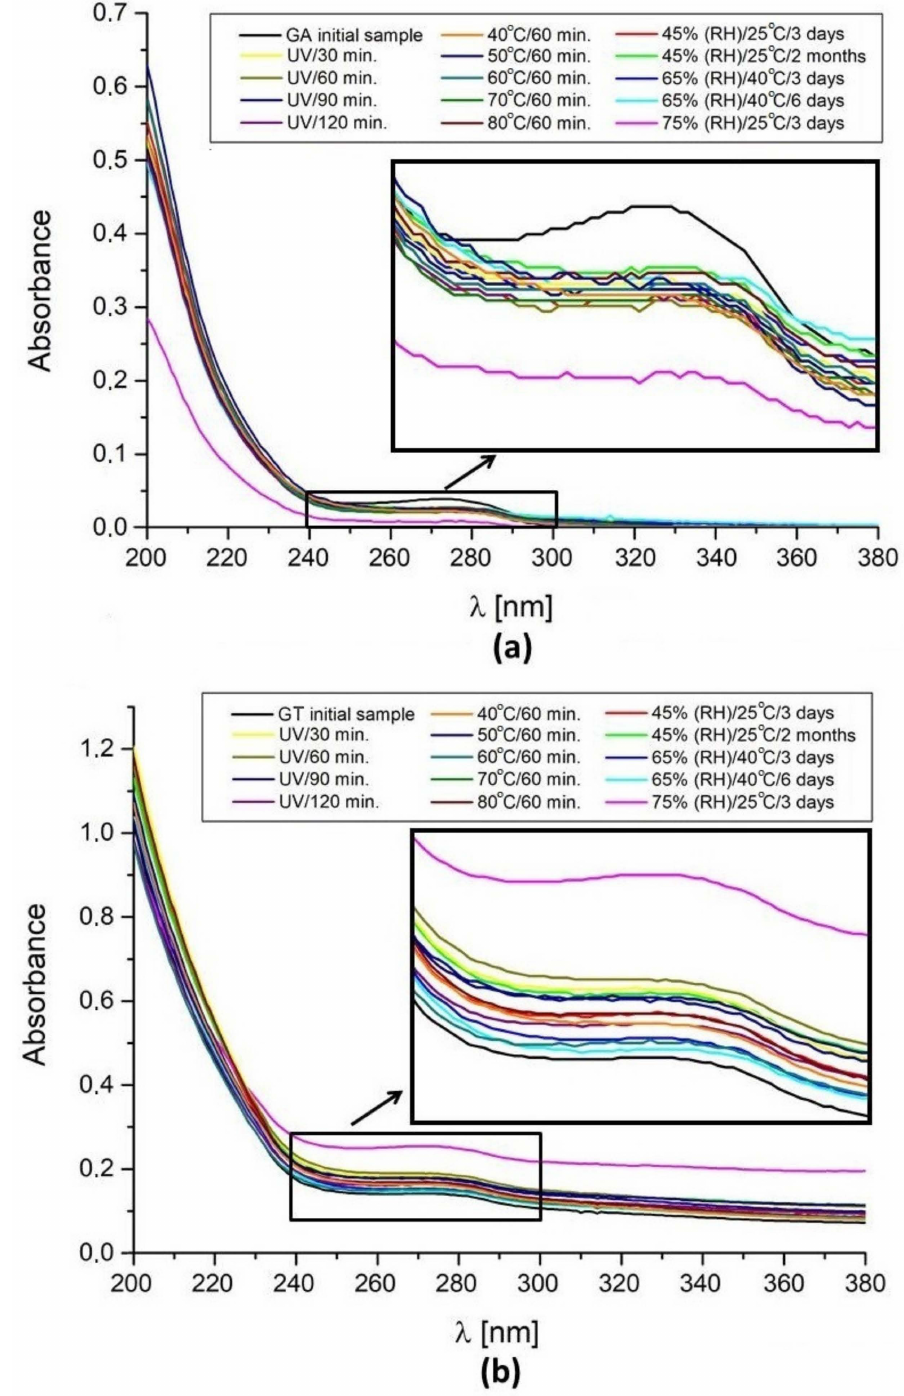
Figure 5. UV spectra of ( a ) gum arabic, and ( b ) gum tragacanth in the tested storage conditions. Measurements was performed at room temperature in the wavelength range 200–380